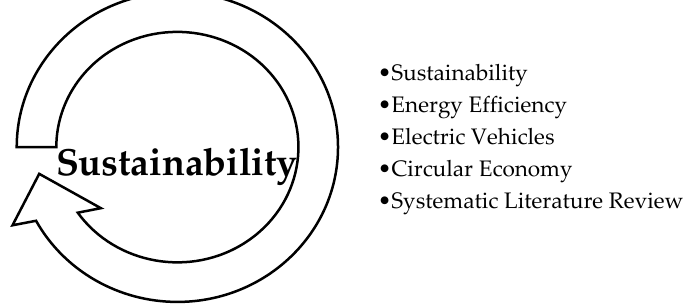
Figure 14. Main topics of the Sustainability Cluster.